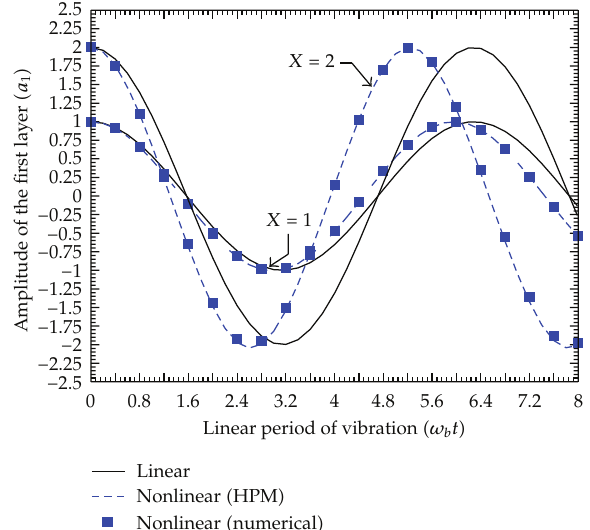
Figure 7: Variation of the nondimensional amplitude ratio versus the linear period of a C-C SWNT (cid:3) k (cid:8) 10 7 N/m 2 (cid:4)